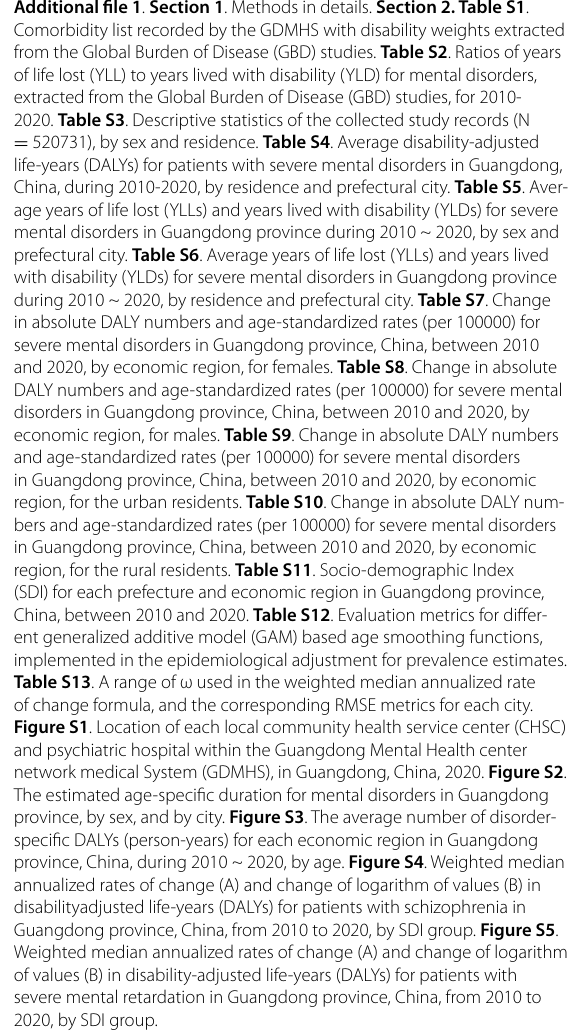
Figure S1 . Location of each local community health service center (CHSC) and psychiatric hospital within the Guangdong Mental Health center network medical System (GDMHS), in Guangdong, China, 2020. Figure S2 . The estimated age-specific duration for mental disorders in Guangdong province, by sex, and by city. Figure S3 . The average number of disorder- specific DALYs (person-years) for each economic region in Guangdong province, China, during 2010 ~ 2020, by age. Figure S4 . Weighted median annualized rates of change (A) and change of logarithm of values (B) in disabilityadjusted life-years (DALYs) for patients with schizophrenia in Guangdong province, China, from 2010 to 2020, by SDI group. Figure S5 . Weighted median annualized rates of change (A) and change of logarithm of values (B) in disability-adjusted life-years (DALYs) for patients with severe mental retardation in Guangdong province, China, from 2010 to 2020, by SDI